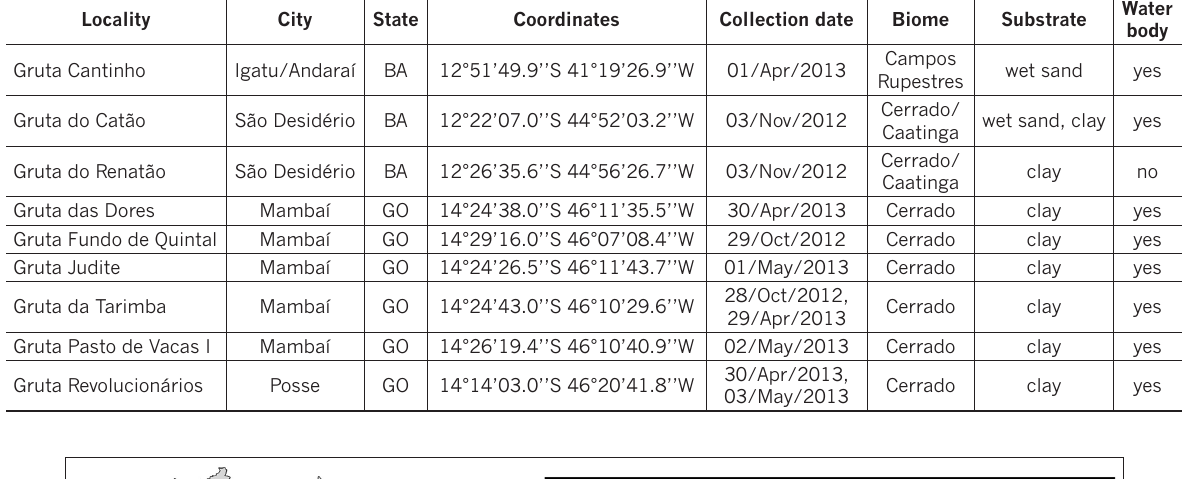
Table 1. List of all localities, i.e., the caves (or “grutas” in Portuguese), where the present material was collected, alongside their city/municipality, state, coordinates (see also Fig. 1), date of collection, the biome of the surrounding area, the microhabitat where the snails were collected and if there is a water body inside each cave.